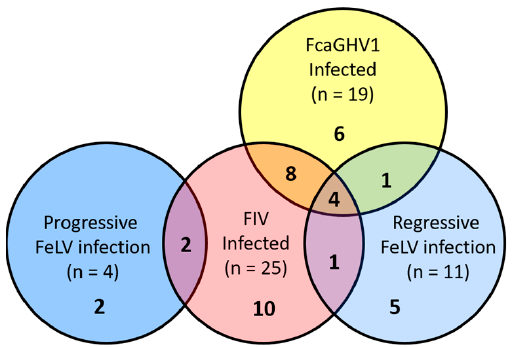
Figure 1. Infection status of lymphoma cases. The total number of infections by each virus is presented in parentheses. Single and coinfections are represented by the numbers in bold. Eighty-three cats with lymphoma tested negative for all 3 viruses. Viruses 2018 , 10 , x FOR PEER REVIEW 6 of 13